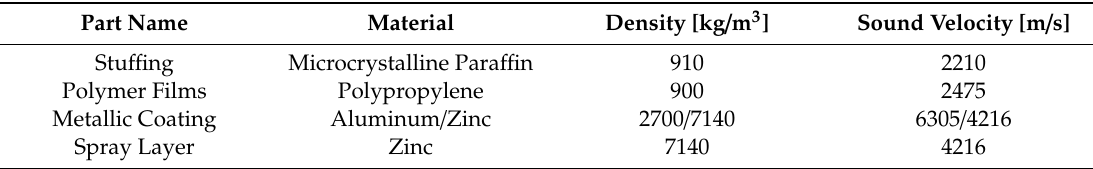
Table 1. Material properties of MFCs.